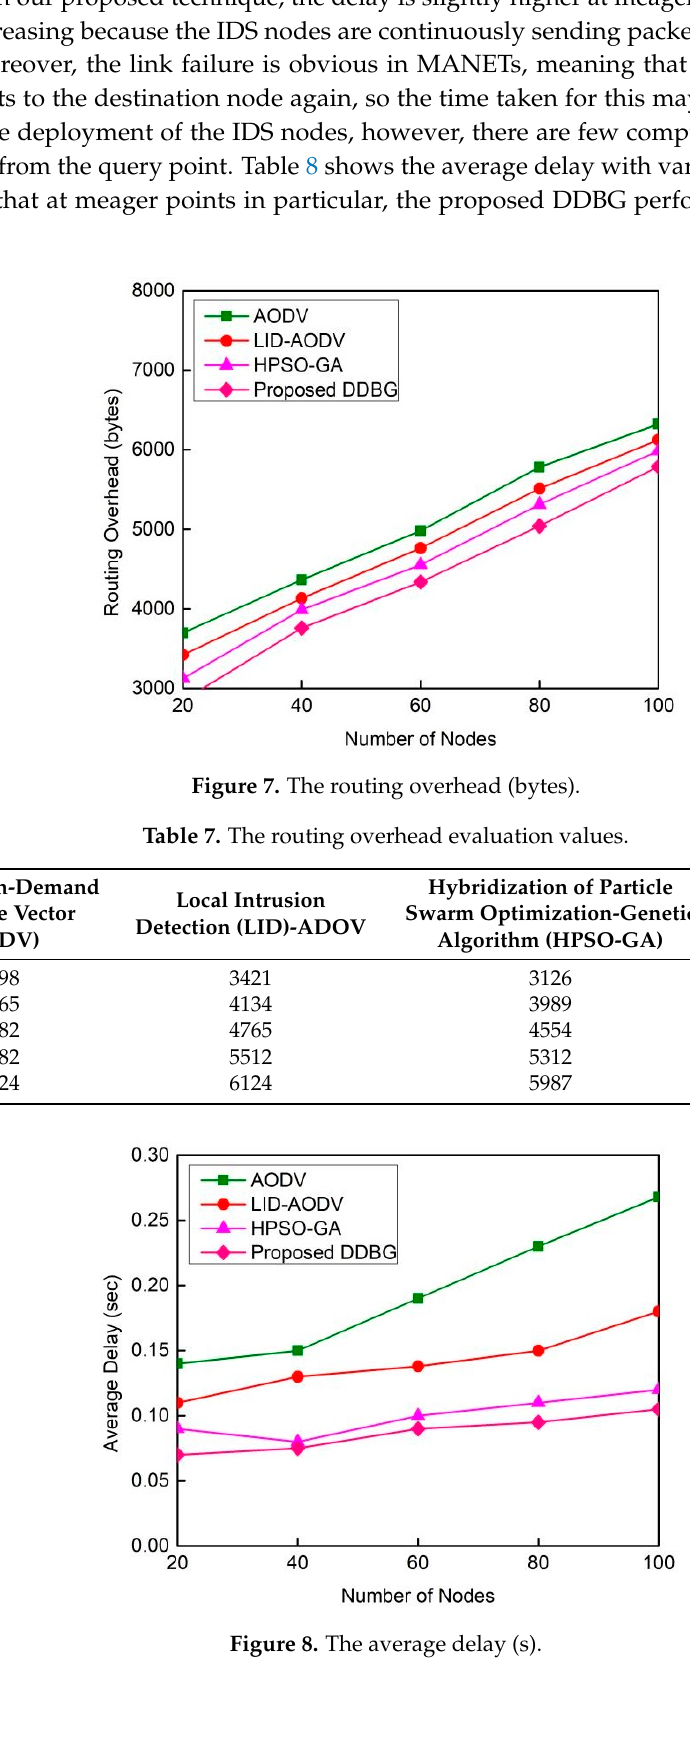
Table 7. The routing overhead evaluation values.